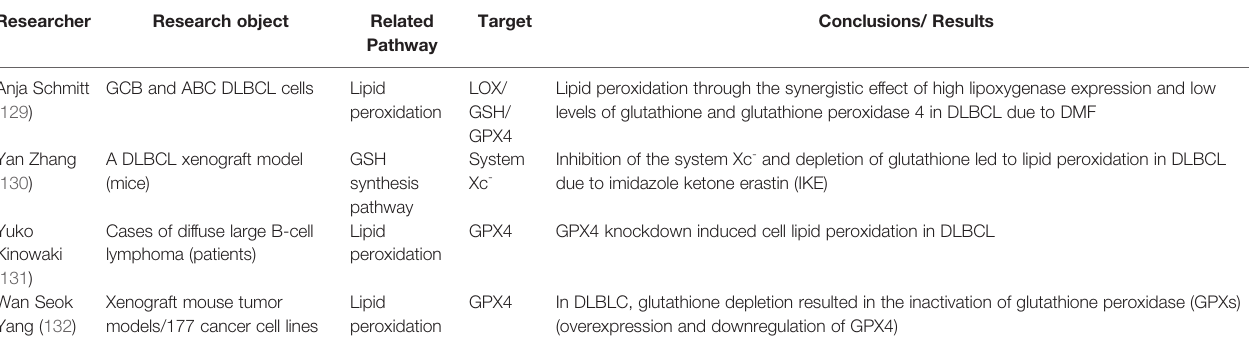
TABLE 3 | Research progress on ferroptosis in diffuse large B-cell